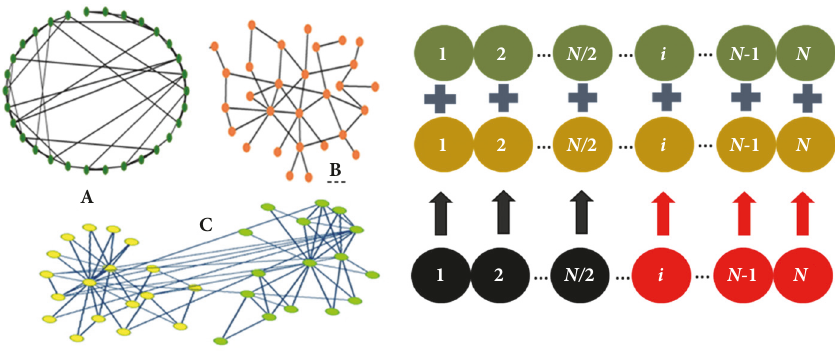
Figure 1: (Color online) Schematic of different topological structures of three